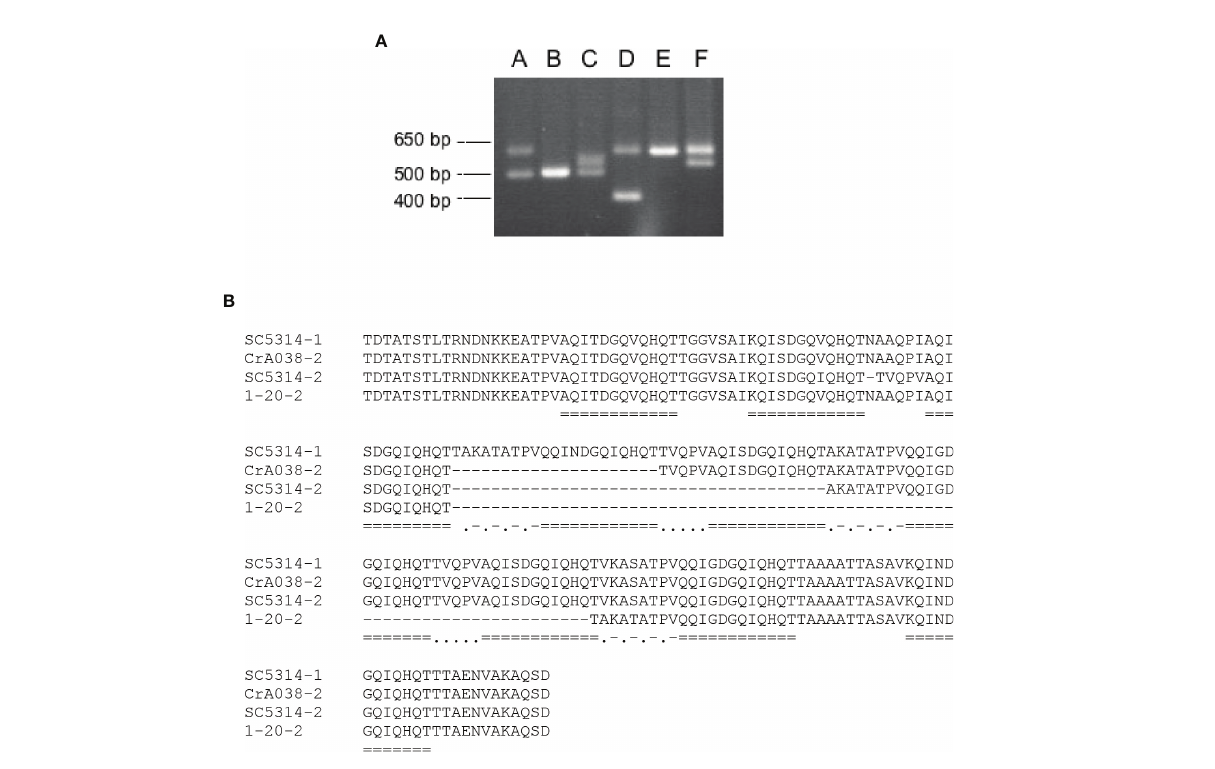
FIGURE 6 | Variation among C. albicans PIR1 alleles attributed to the repeat-containing region. (A) Six different patterns of PCR products ampli fi ed using primer pair 3/4 ( Supplementary Figure S12 ) and genomic DNA from a diverse collection of C. albicans isolates ( Supplementary Table S4 ). Patterns were labeled A through F, corresponding to DNA ampli fi ed from strains SC5314, 1-178, 1-233, 1-20, OpA052, and CrA038, respectively. Molecular size markers are on the left of the image. (B) Alignment of the Pir1 amino acid sequences translated from the four alleles shown in (A) . PIR1 alleles from SC5314 had 9 and 7 copies of the repeated sequence (called SC5314-1 and SC5314-2, respectively). The smaller PIR1 allele from strain CrA038 (CrA038-2) had 8 repeat copies and the smaller allele from strain 20-2 (20-2-2) had 5 copies. Repeated sequences were marked by double underlining. Dots and dashes marked a conserved intervening sequence ([A/V] KA [S/T] ATPV). Dots alone marked a different, conserved intervening sequence